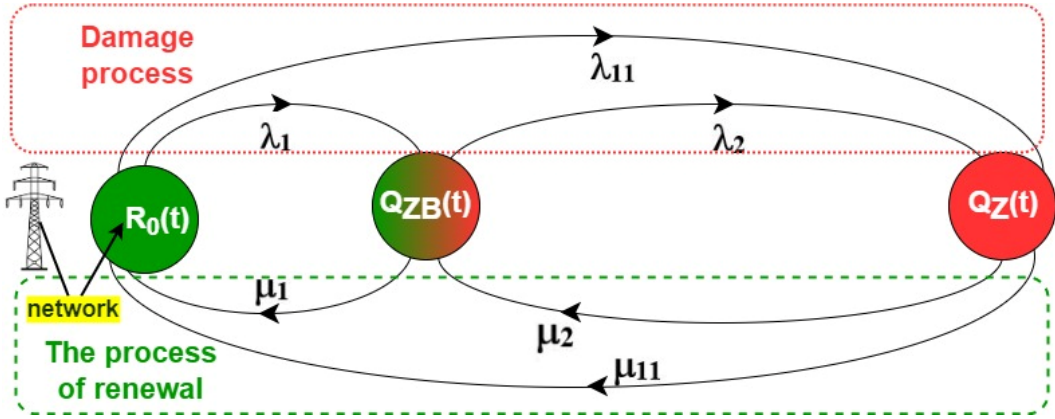
Figure 6. Example of a power supply operation process for an ESS with one redundant (backup) element in the form of a BA–accumulator baery.